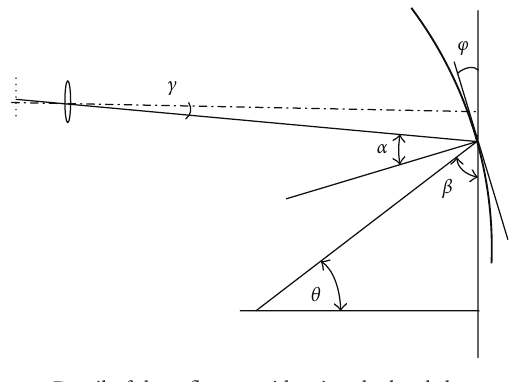
Figure 5: Detail of the reflector evidencing the local slope ϕ of the surface in the observation point.